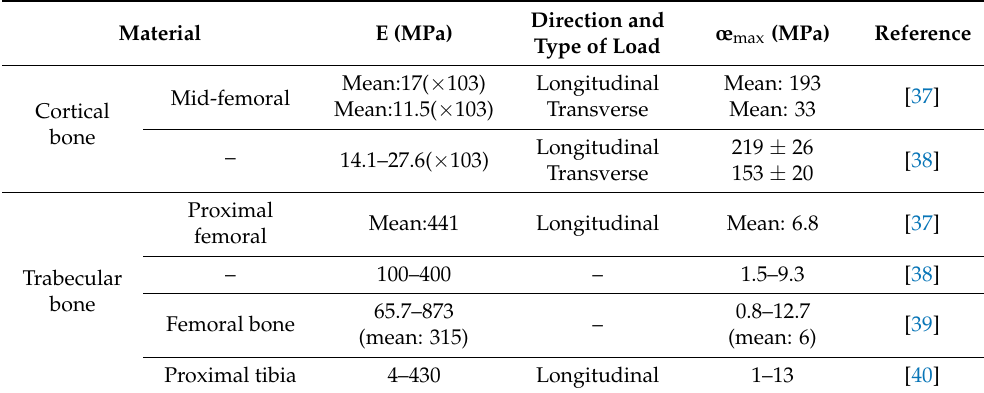
Table 4. Mechanical properties of human cortical and trabecular